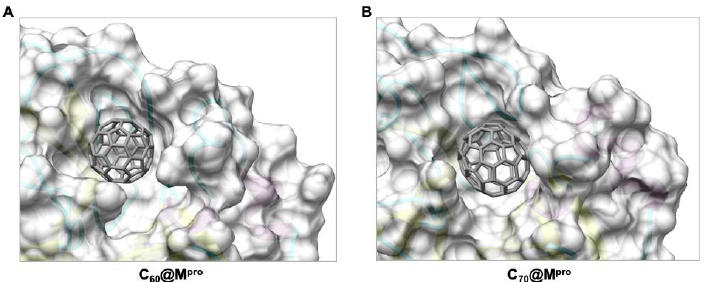
Figure 6 . Surface representation of the binding cleft of ( A ) C 60 and ( B ) C 70 in M pro . The ΔG binding between C 70 and M pro is considerably higher ( − 28.0 kcal mol − 1 ) than in the case of C 60 ( − 18.8 kcal mol − 1 ) (Table 3). Table 3. Energy components of ΔG binding (VDW, E el , E GB , and E non-polar ) for C 60 @M pro and C 70 @M pro complexes. All energies are reported in kcal mol −1